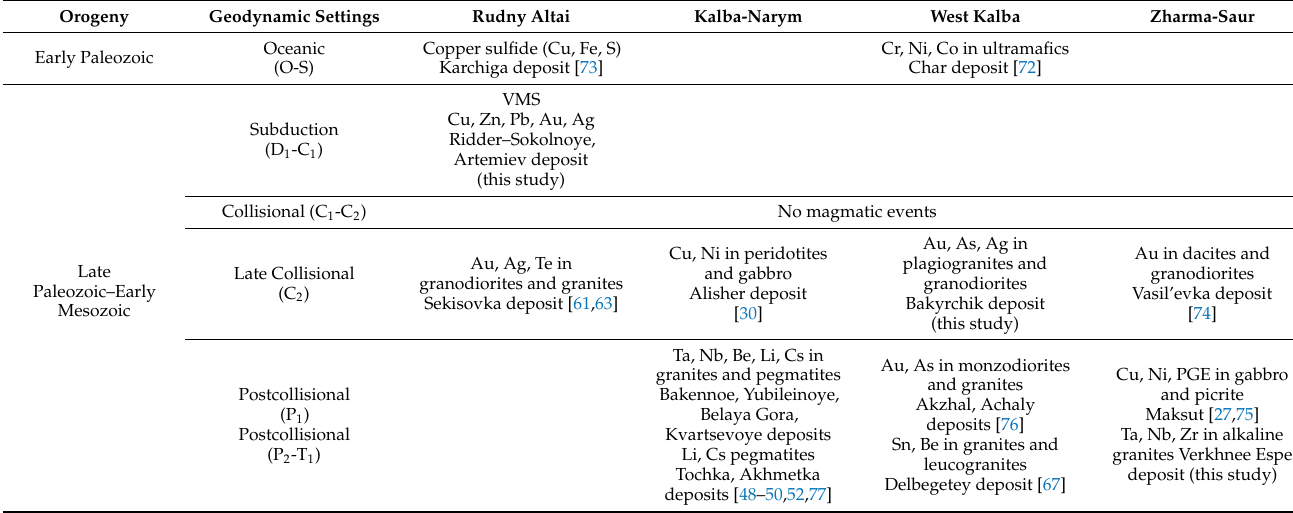
Table 2. Geodynamic settings and mineralization types in different areas of Great